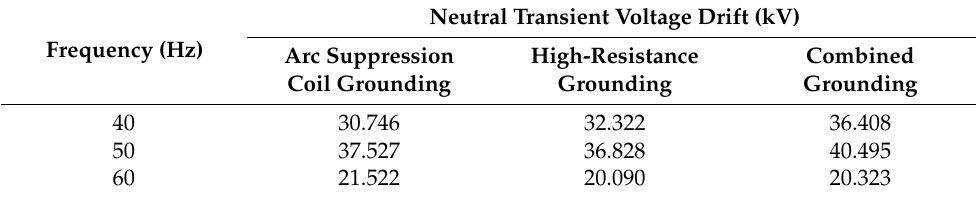
Table 2. Neutral transient voltage drift with different